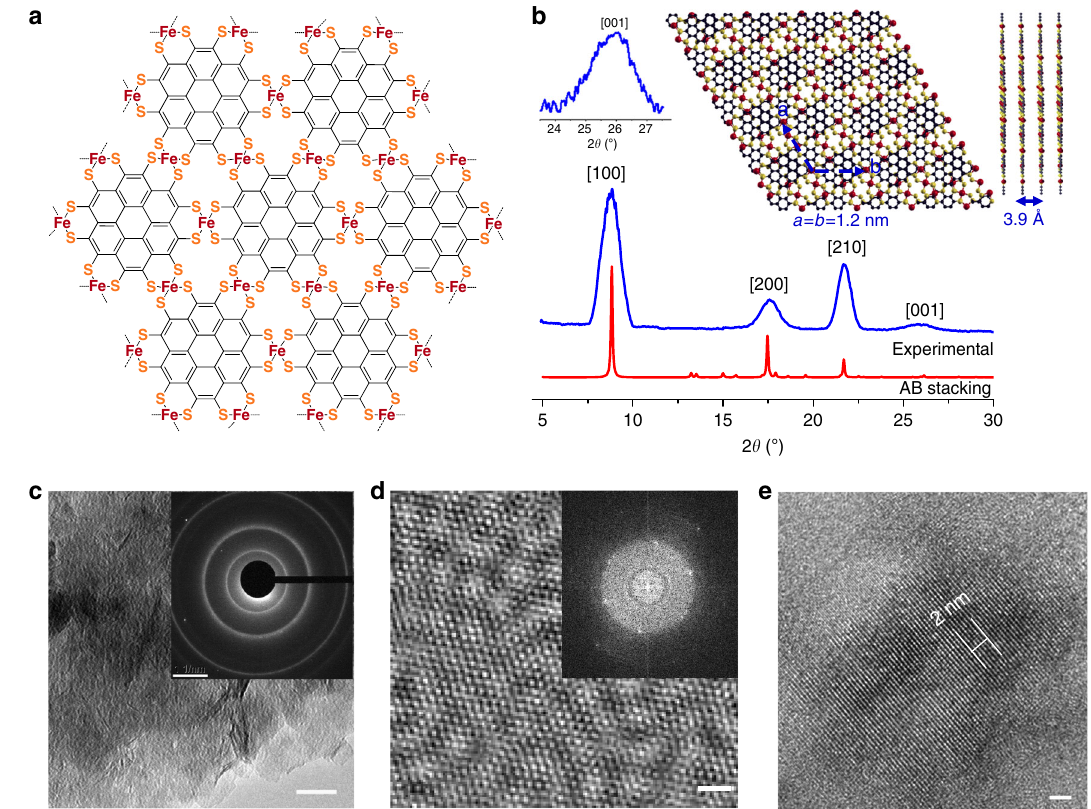
Fig. 1 Structural characterizations of PTC-Fe 2D MOF. a Schematic structure of PTC-Fe. b Experimental and simulated PXRD patterns. Insets: enlarged experimental PXRD peak corresponding to (001) re fl ection and the crystal structure simulation of AB stacking model with 25% shifting in X and Y directions. c transmission electron microscopy (TEM) image. Scale bar = 50 nm. Inset: Selected area electron diffraction (SAED) pattern. Scale bar = 1 nm − 1 . d high-resolution in-plane TEM images. Scale bar = 2 nm. Inset: fast Fourier transform (FFT) pattern from image ( d ). e high resolution TEM image from the side view. Scale bar = 2 nm. The distance across fi ve lattices is 2